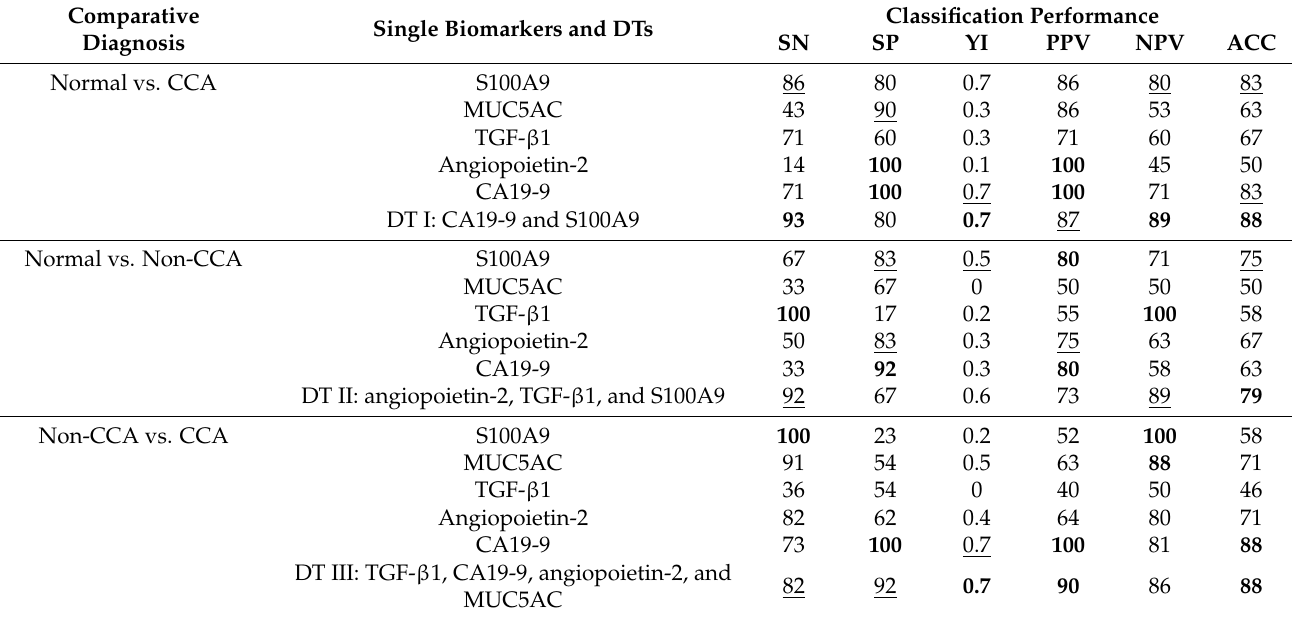
The bold indicates the highest value, while the underline indicates the second-highest value in each category of biomarker diagnostic performance. Abbreviations; SN = sensitivity; SP = specificity; YI = Youden index; PPV = positive predictive value; NPV = negative predictive value; ACC =